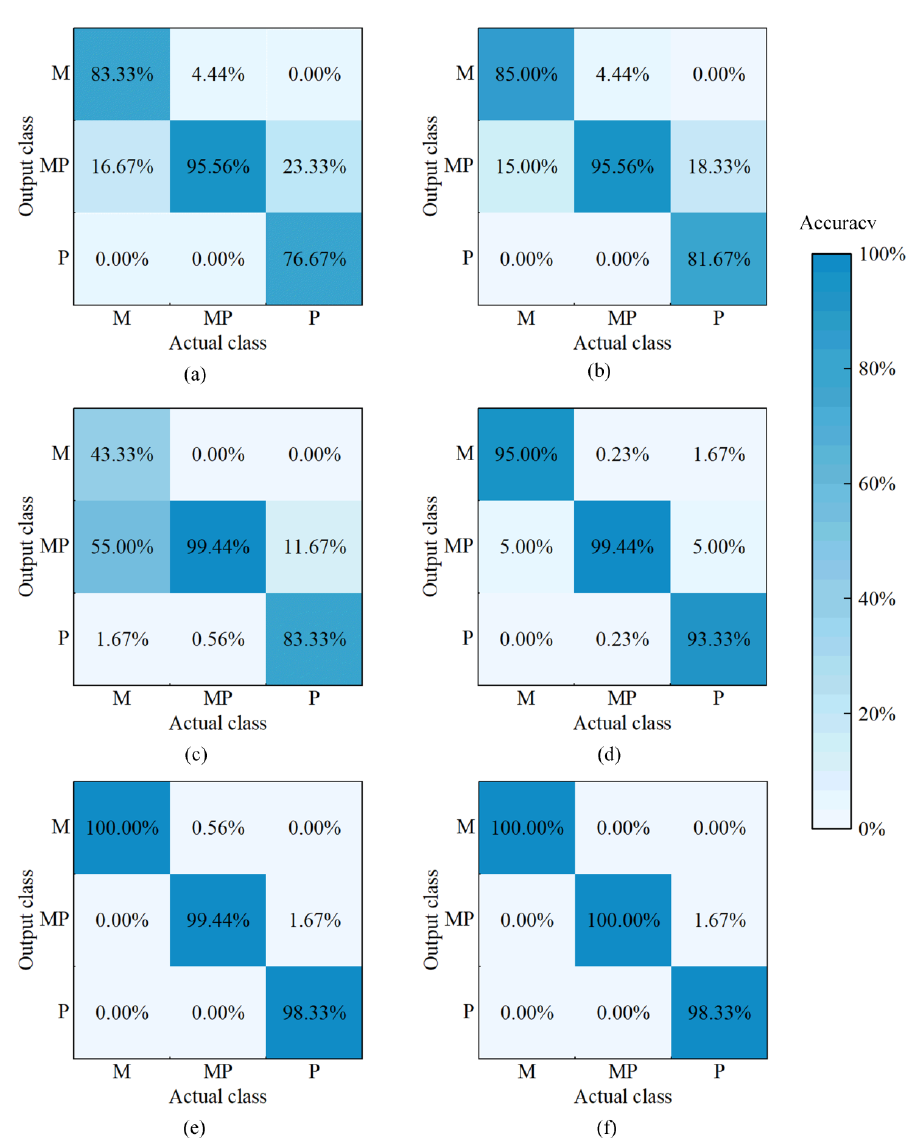
Figure 4. Confusion matrix of accuracy for different models in prediction set. ( a ) BP; ( b ) SSA-BP; ( c ) ELM; ( d ) SSA-ELM; ( e ) SVM; ( f ) SSA-SVM. M, P and MP represent mutton, pork, adulterated mixture, respectively. Table 2. The prediction results in each data set using the basic models and the optimisation models.